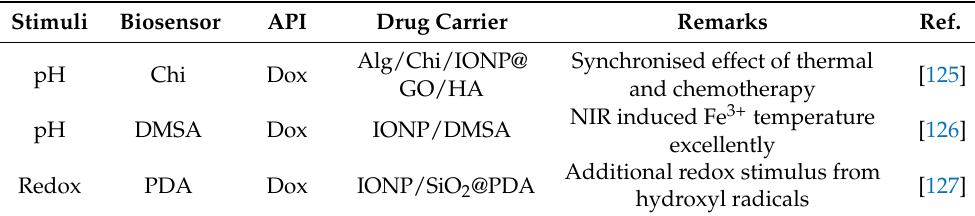
Table 4. Photothermal triggers added a magnetic-aid targetor with pH or redox stimuli in drug carriers with biosensors, with remarks